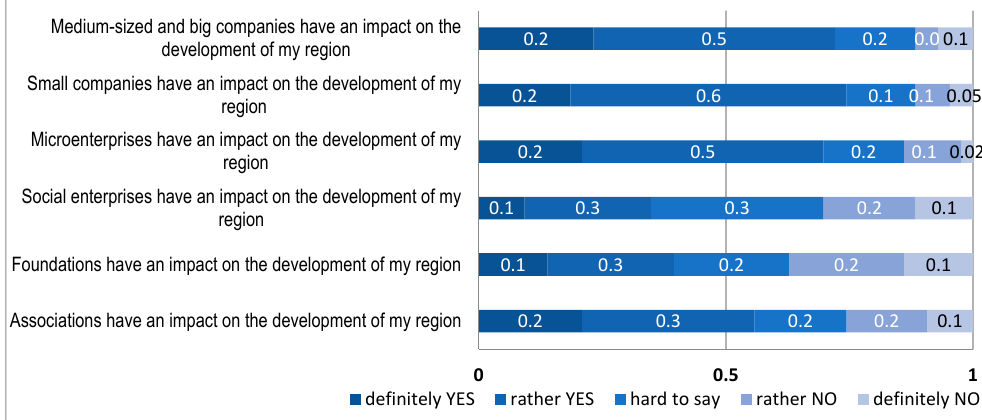
Figure 3. The opinion on the impact of different entities on the rural development.